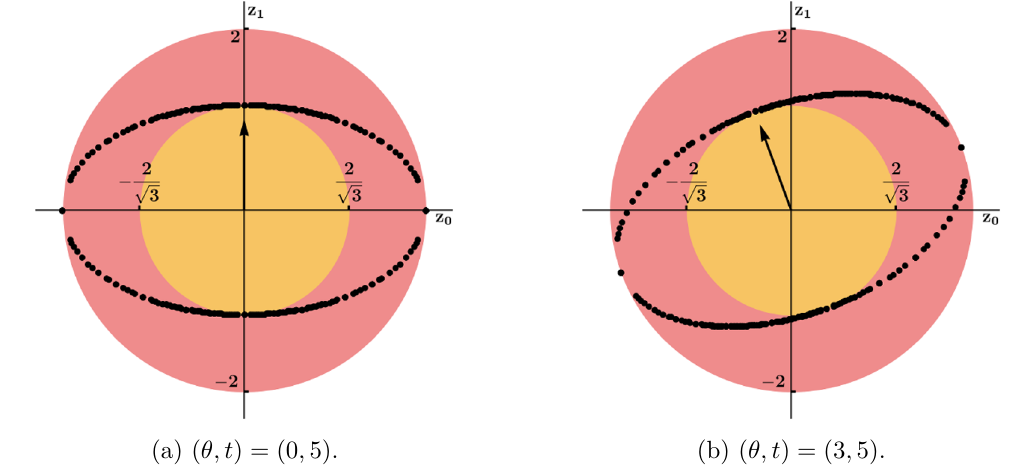
Figure 1. The charge-to-mass ratios of BPS states in a one-modulus compactification. On the left, the axion is set to zero, while on the right, the axion is non-zero. The black arrow a principle axis of the